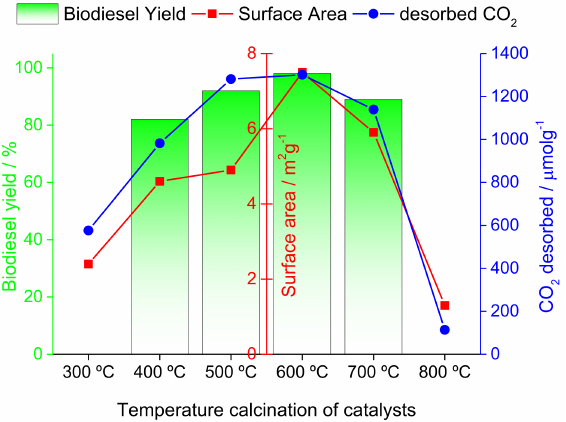
Figure 37. Palm oil transesterification catalyzed by CaO/Nb 2 O 5 , represented by the calcination temperature, in methanol. Reaction conditions: molar ratio methanol: palm oil (12), catalyst (3 wt%), temperature (65 ◦ C), time (2 h) (adapted from